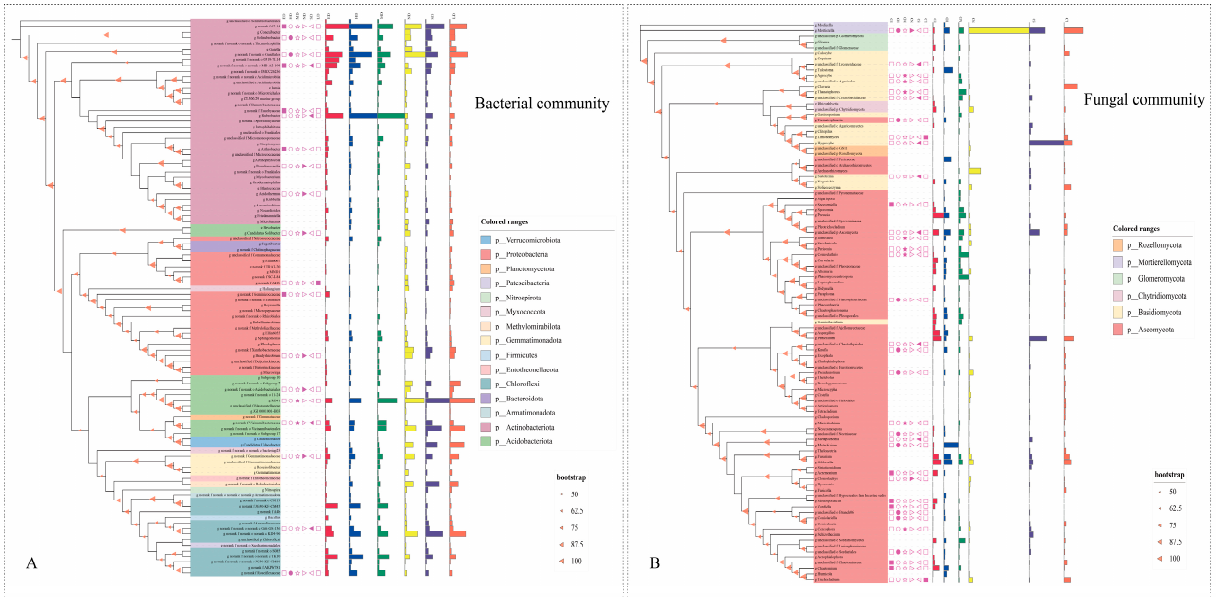
Figure 4. Phylogenetic relationships of the bacterial ( A ) and fungal ( B ) communities at the genus level (results visualized using iTOL tool). The triangles on the branches represent bootstrap values; the phylogenetic trees are colored according to phyla. The purple solid geometric patterns with different shapes represent the significantly different microbes in the six plots. The length of each bar on the right sides represents the normalized mean relative abundance of a